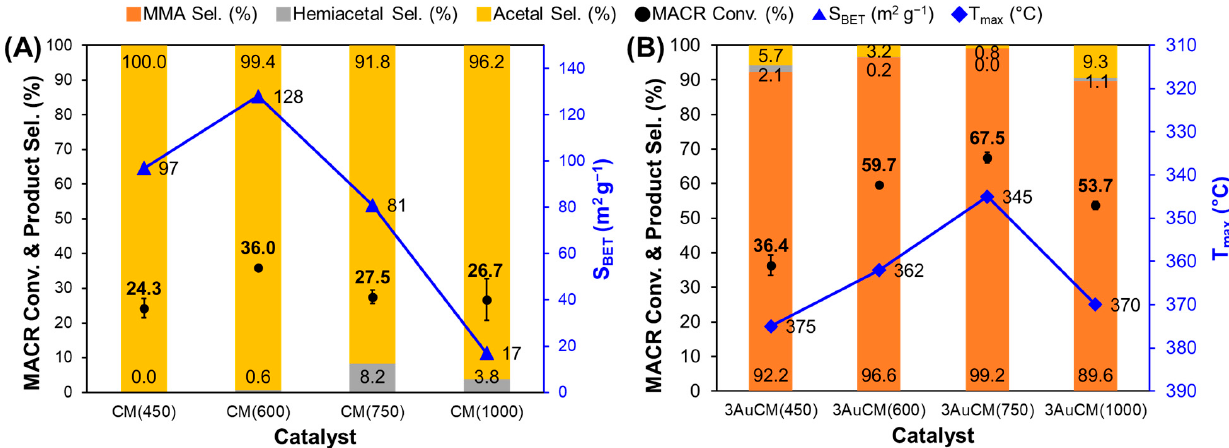
Figure 6. Reaction summaries showing the MACR conversion and product selectivity with CeO 2 –Mg(OH) 2 in the ( A ) absence or ( B ) presence of Au nanoparticles. The black circles indicate MACR conversion. The orange, gray, and yellow bars correspond to the selectivities of MMA, hemiacetal, and acetal, respectively. The blue guidelines with triangles in ( A ) indicate the BET surface areas (S BET ) of CeO 2 –Mg(OH) 2 supports. The blue guidelines with diamonds in ( B ) indicate the maximum desorption temperature (T max ) of the CeO 2 –Mg(OH) 2 supports, as determined from the CO 2 TPD–MS profiles shown in Figure 3C.